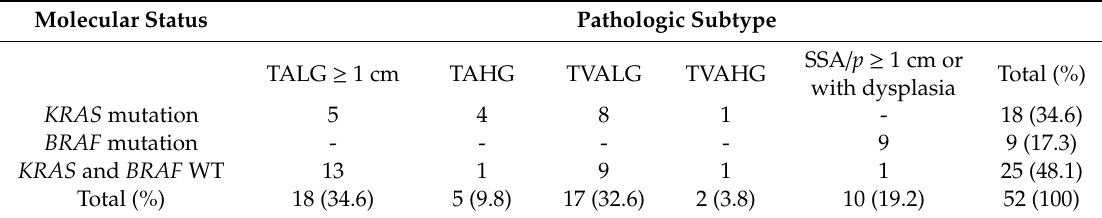
Table 2. Molecular status of advanced adenomas according to the pathological subtype.